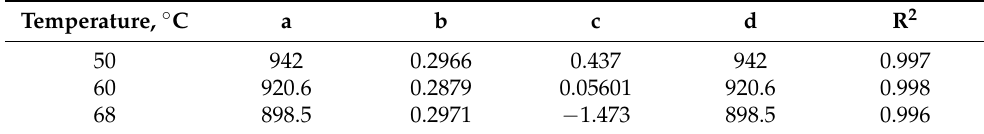
Table 1. Fit function coefficients with the goodness of fit. Temperature, ◦